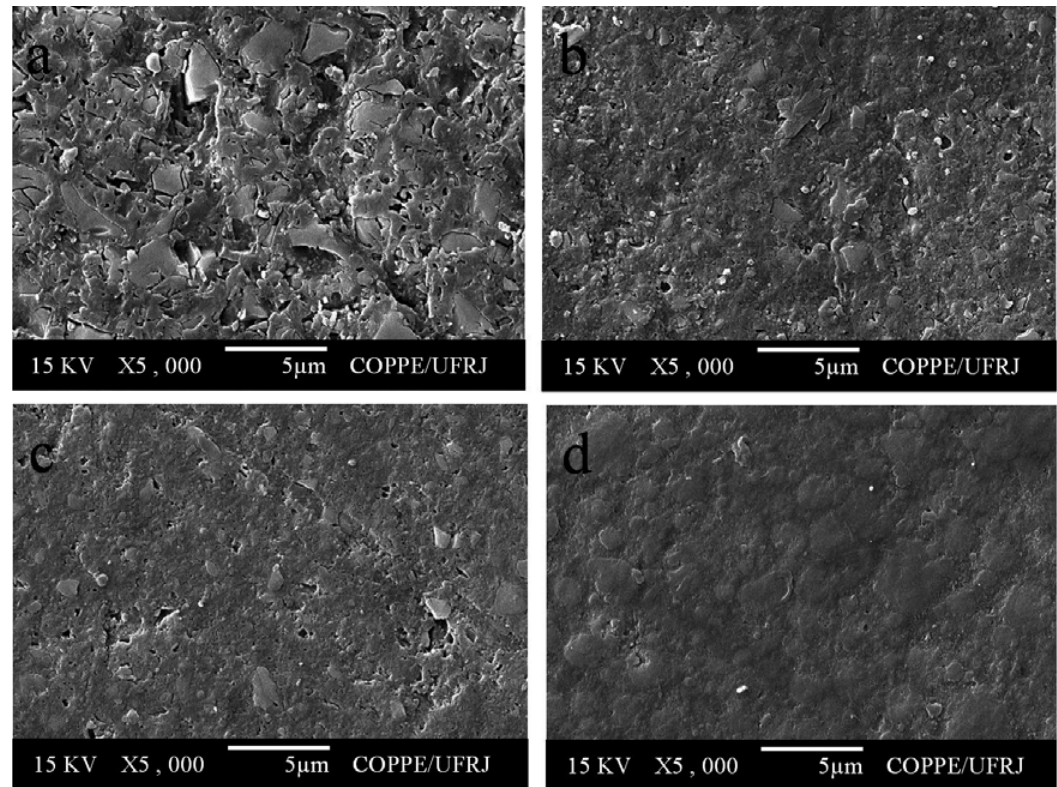
FIGURE 5- Representative SEM photomicrographs of resin-based composites after pH-cycling and immersion in Claritin ® .